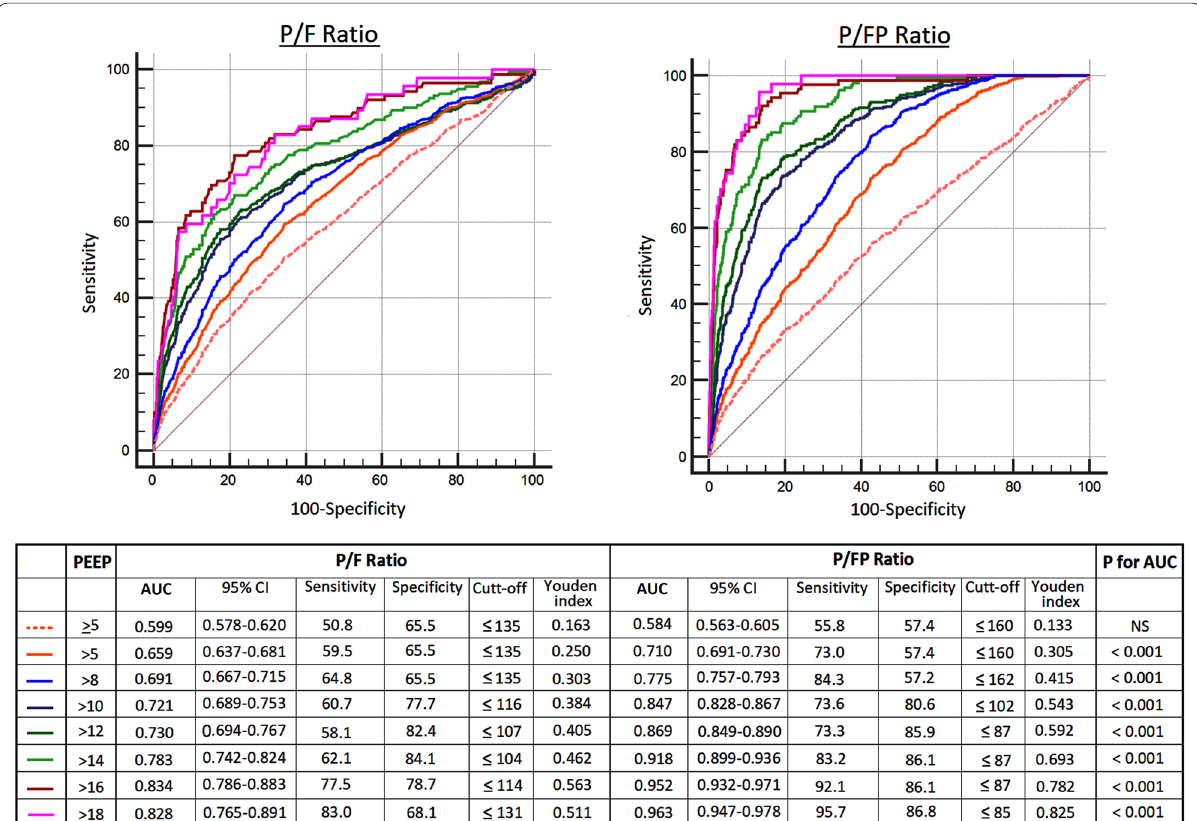
Fig. 3 Receiver operating characteristic curves for the P/F ratio and the P/FP ratio for hospital mortality at different PEEP thresholds. AUC area under the curve; NS not significant, PEEP positive end-expiratory pressure, P/F inspired oxygen